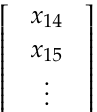
Table 4. Training set and prediction set settings for each intrinsic mode function (IMF).